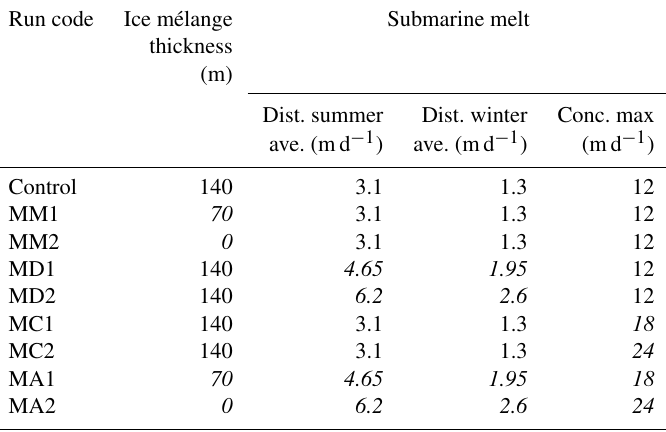
Table 1. Simulations performed in the sensitivity analysis. Run codes begin “M” to distinguish magnitude perturbations as opposed to duration (D) perturbations (Sect. S1 in the Supplement). Two simulations each were performed for mélange (M), distributed melt (D), concentrated melt (C) and all (A) forcings. The digit refers to either the first or second perturbation, where the second is more “severe”. The parameter values which deviate from the control simulation are shown in italics (i.e. the active